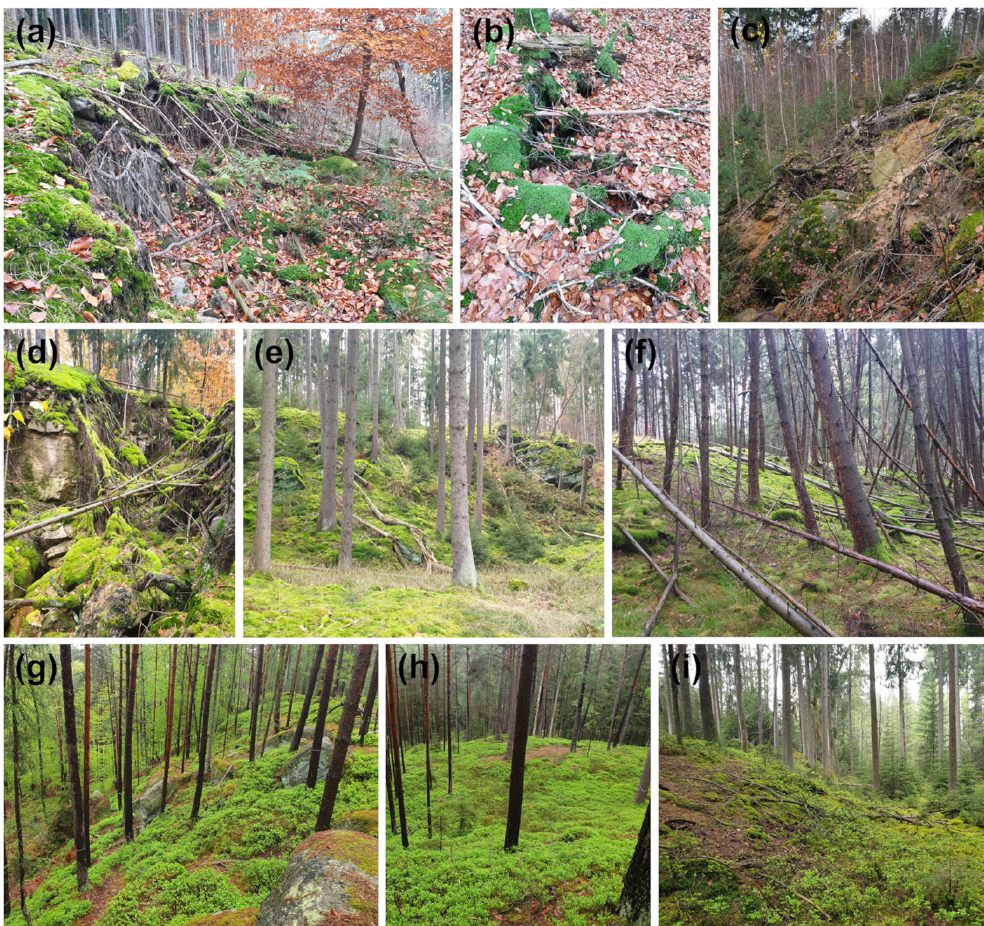
Figure 4. Photos of (a, b) lateral roots under tension located at the head scarp and (c) at a secondary scarp of the Putzenstein landslide. (d) Rhätolias boulders at the head scarp, (e) overview of the head scarp and (f) tilted trees at the toe of the Weinreichsgrab landslide. (g, h) Overview of the head scarp and (i) the toe of the Fürstenanger